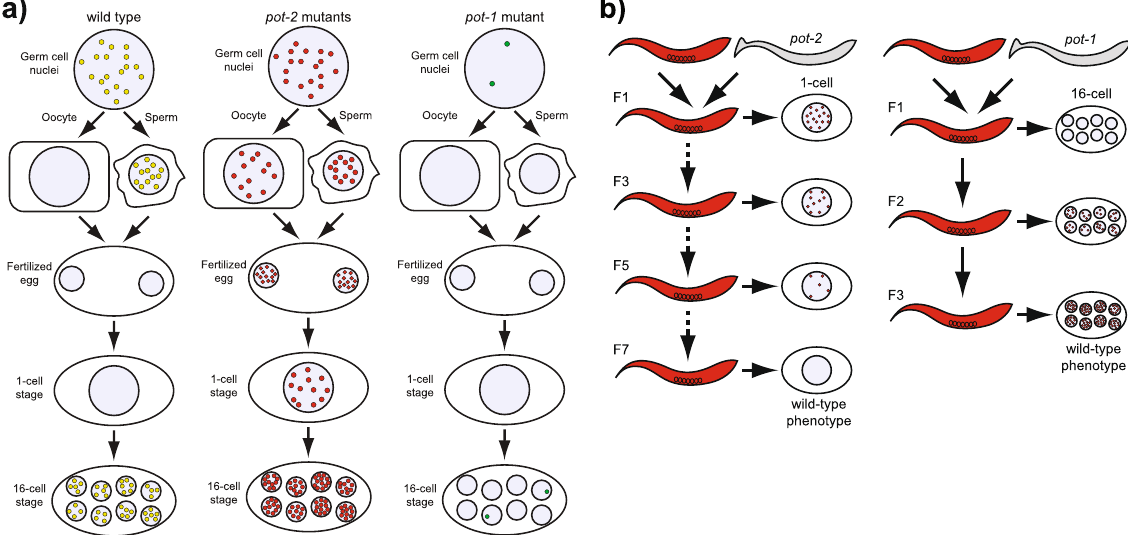
Fig. 4 Models of Pot1 focus dynamics. a Descriptive model of the developmental timing of Pot1 foci localization in wild type, pot-2 mutants, and pot-1 mutants. Red circles indicate POT-1::mCherry, green circles indicate mNeonGreen::POT-2, and yellow circles indicate colocalization of both transgenic proteins. b Descriptive model of the heritable phenotypes of progeny of gametes from pot-2 or pot-1